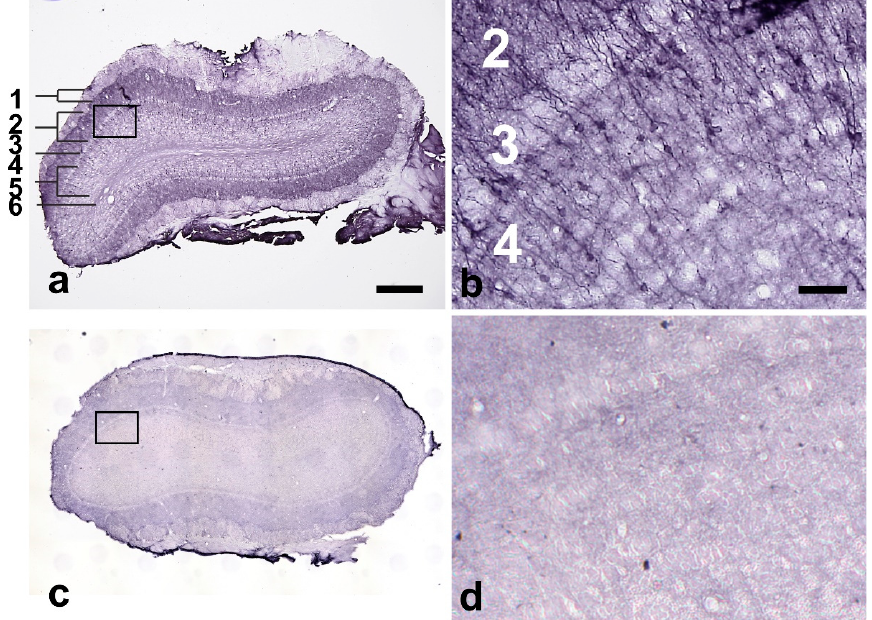
Figure 4. The figure shows 30 µm-thick sections immunohistochemically stained for cleaved SNAP-25 of the right olfactory bulb of a rat injected with 1 ng of BoNT-A into the right CPu 2 weeks before ( a , b ) and a rat injected with vehicle solution only 12 months before ( c , d ). ( a , c ) Overview of the olfactory bulb section. The rectangle marked in ( a ) is shown enlarged in ( b ). The rectangle marked in ( c ) is shown enlarged in ( d ). Cleaved SNAP-25-positive perikarya and fibers are detectable in ( a , b ) but not in ( c , d ). Note that in addition to the nerve fibers, neuronal cell bodies are clearly immunoreactive for cleaved SNAP-25 in ( a , b ). The individual layers of the olfactory bulb are annotated by numbers ( a , b ) and markings (in ( a )), 1: periglomerular layer, 2: external plexiform layer, 3: mitral cell layer, 4: internal plexiform layer, and 5: granular cell layer. The scale bar in ( a ) corresponds to 500 µm for ( a , c ), and that in ( b ) to 50 µm for ( b , d ).